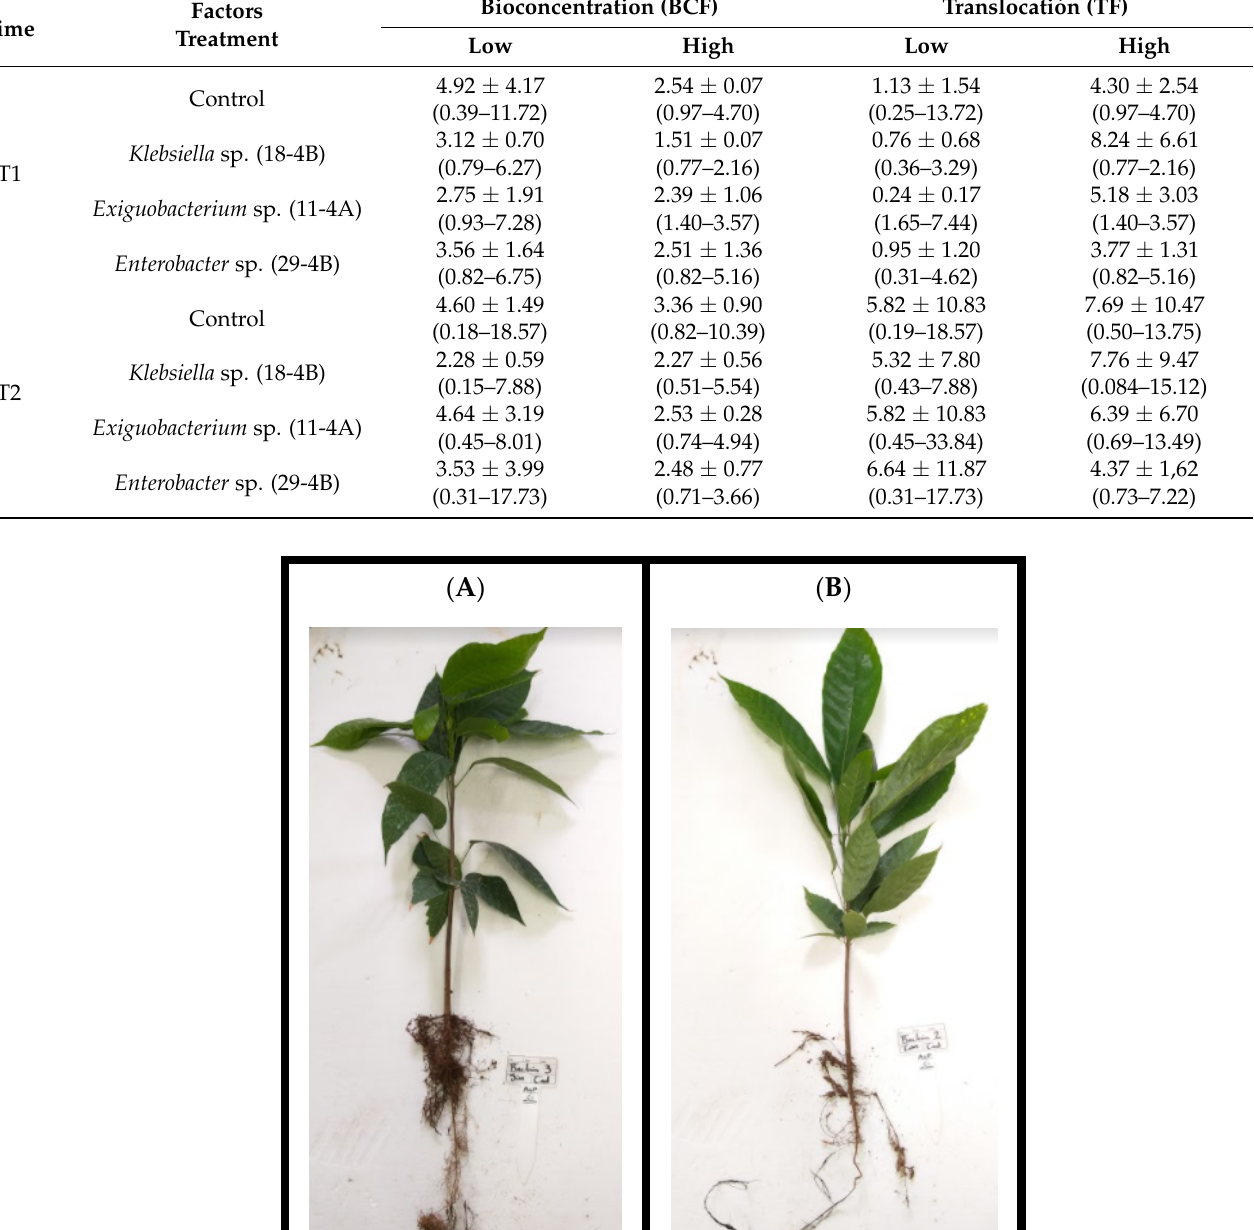
Table 6. Bioconcentration and translocation factors (mean, SD, min.–max.) for all treatments.